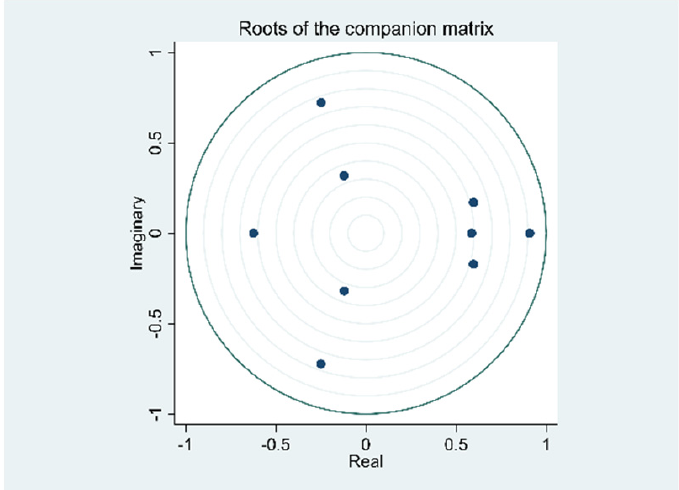
Figure 5. Balance test of data concerning the electricity consumption of the industry sector.